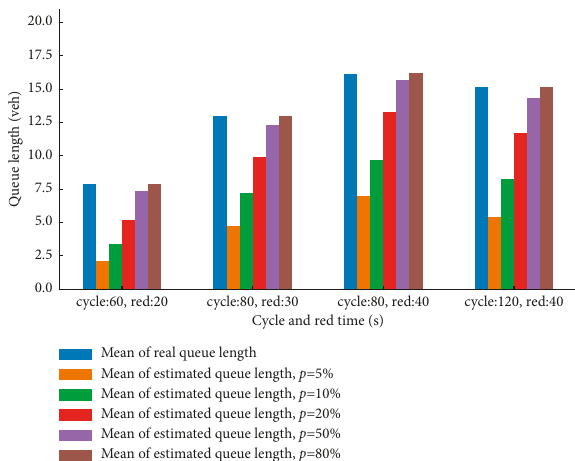
Figure 8: Estimation results under different cycle and red times.